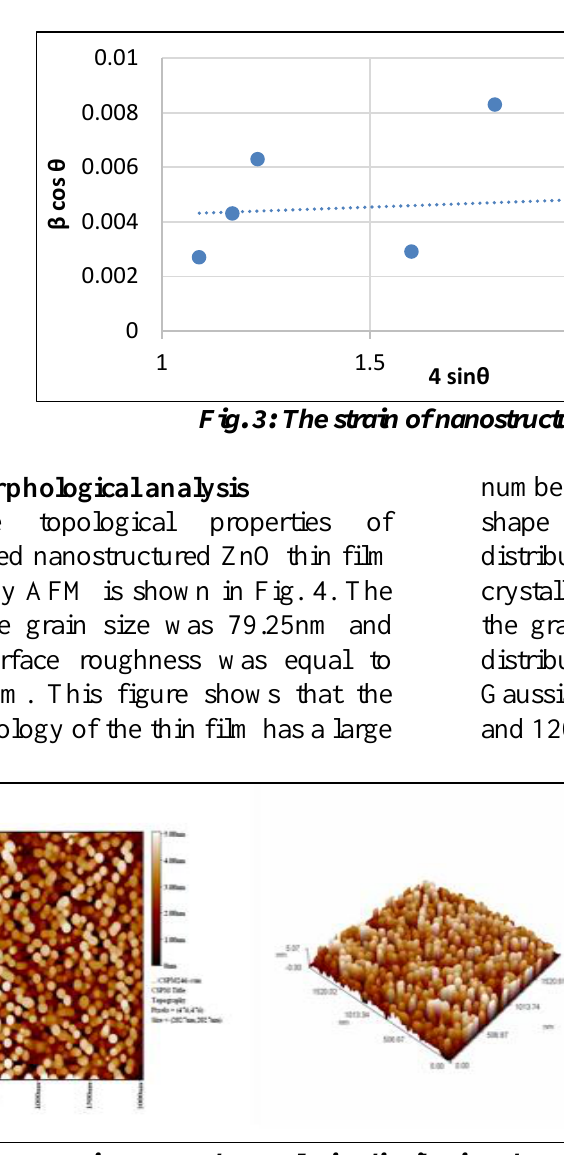
Fig. 4: 2D, 3D images and granularity distribution chart of the atomic force microscopy for the nanostructured ZnO thin